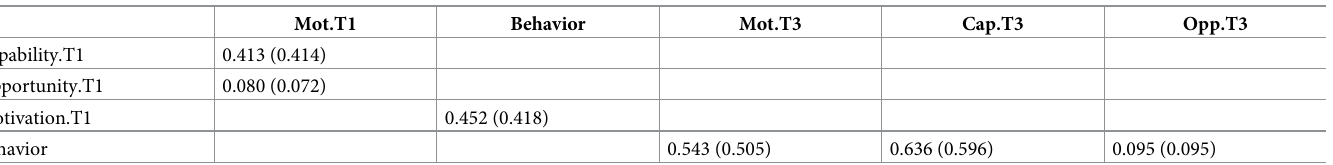
Table 2. Cohen’s f 2 . Initial model (Adjusted